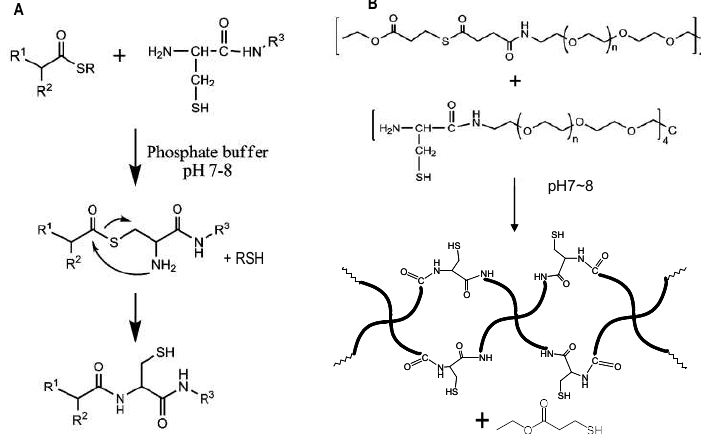
Figure 8. ( A ) A general scheme of NCL. ( B ) Catalyst-free in situ hydrogel crosslinking by native chemical ligation. Four-armed PEG macromonomers terminated with N -terminal cysteine and thioester groups crosslink to form gels in aqueous media at pH 7~8. Image reproduced with permission from [35]. Copyright 2009 ACS.